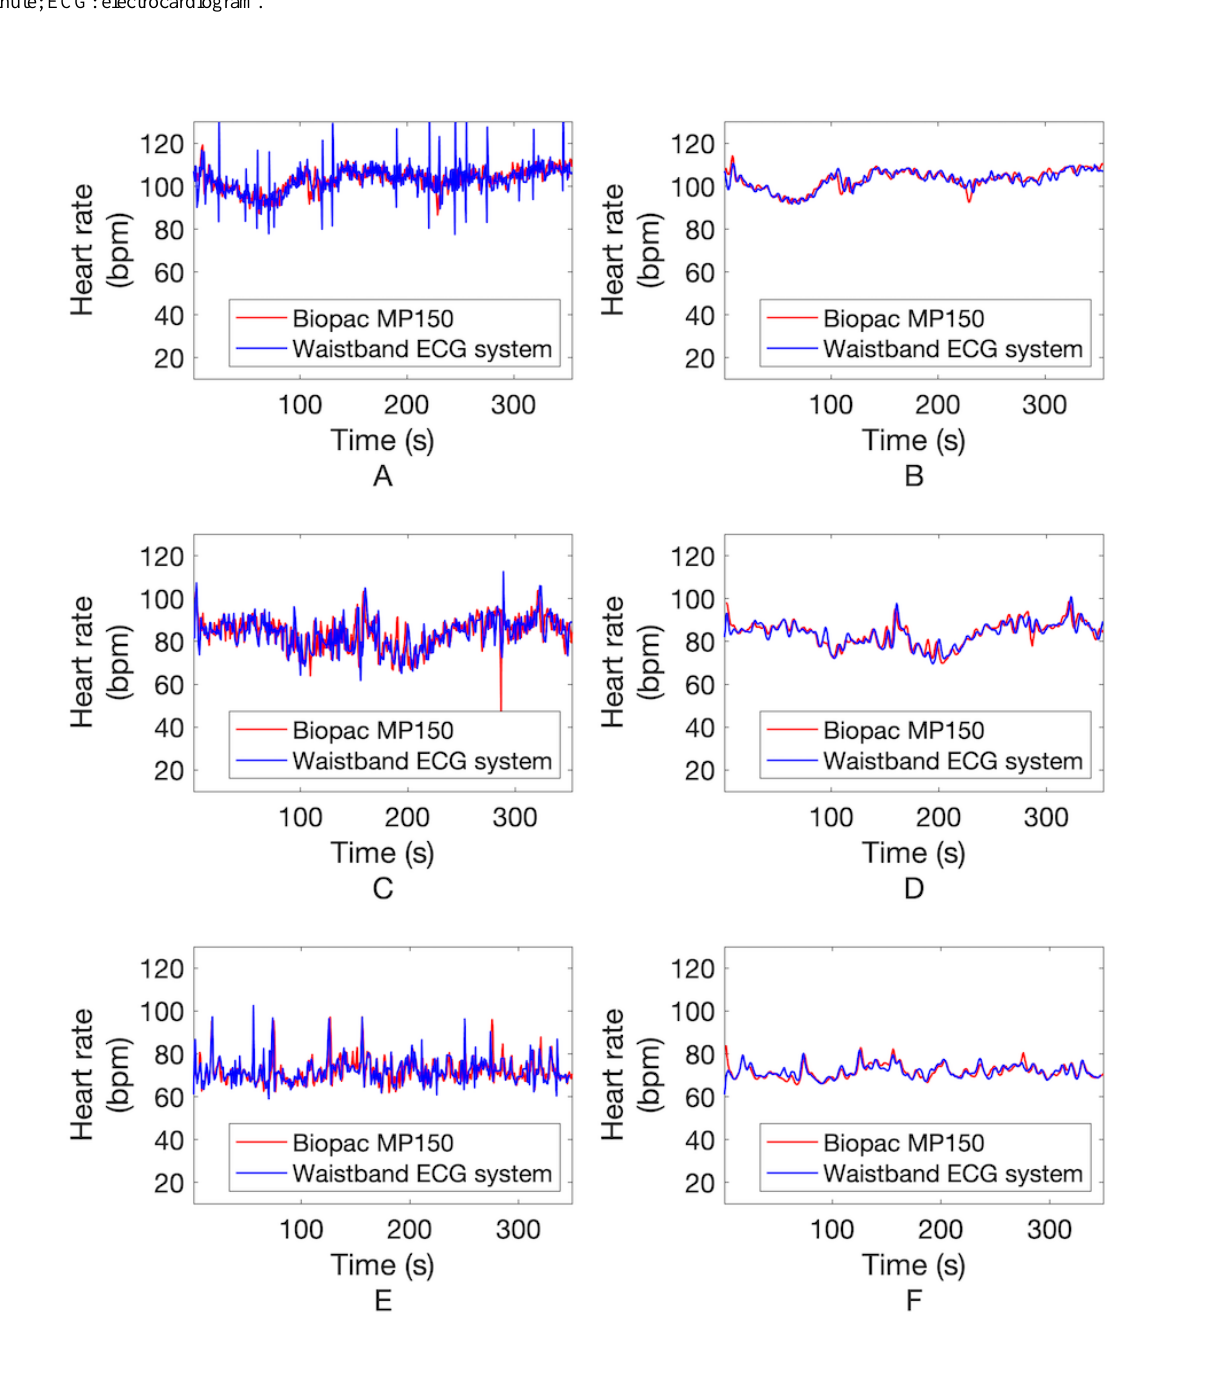
Figure 8. Bland-Altman and Pearson correlation plots. Bland-Altman plot (A) and Pearson correlation plot (B) in standing position. Bland-Altman plot (C) and Pearson correlation plot (D) in sitting position. Bland-Altman plot (E) and Pearson correlation plot (F) in lying position. bpm: beats per minute; ECG: